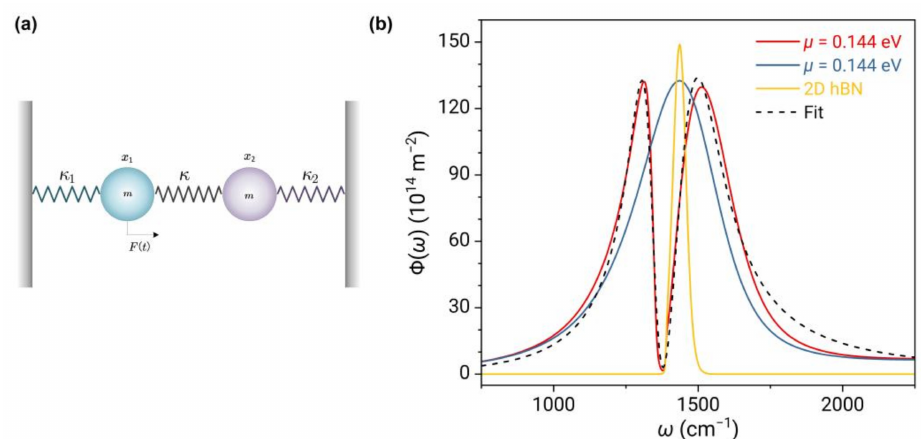
Figure 6. ( a ) Coupled oscillator model. κ 1 , κ 2 , and κ are spring constants, m is the mass and F ( t ) is the driving force. ( b ) Spectra of energy transfer function Φ ( ω ) of graphene (blue curve), 2D hBN (yellow curve), and 2D vdW heterostructure (red curve) at µ = 0.144 eV. The dashed curve represents the fitted curve using Equation